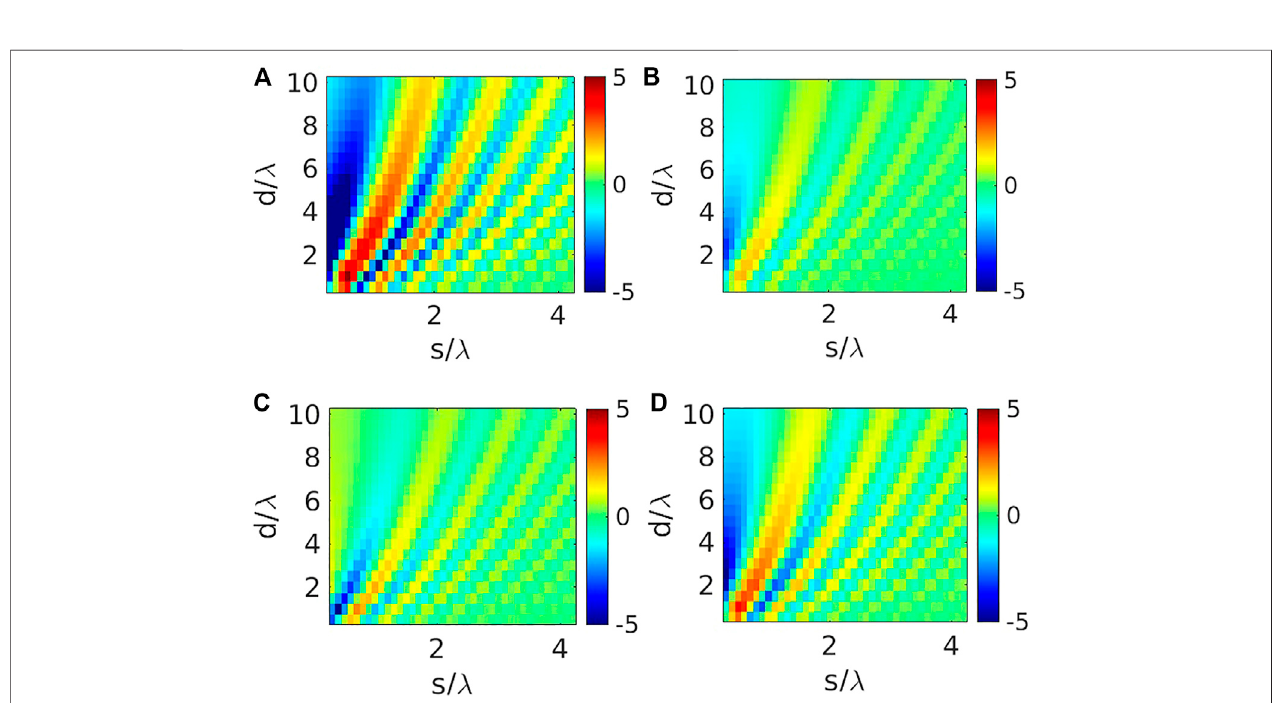
FIGURE6| Variationof Δ P (indB)considering4 × 4IRSnearTx-dipole(see Figure5 ),consideringtheinputimpedance Z in , L forindividualloopsas: (A) 96.57+j0 Ω , (B) 2096.57 + j0 Ω , (C) 96.57 – j865.30 Ω , (D) (c) 96.57 + j865.30 Ω . We keep r (cid:1) 0.1 λ and p (cid:1) 2 r +2 mm.